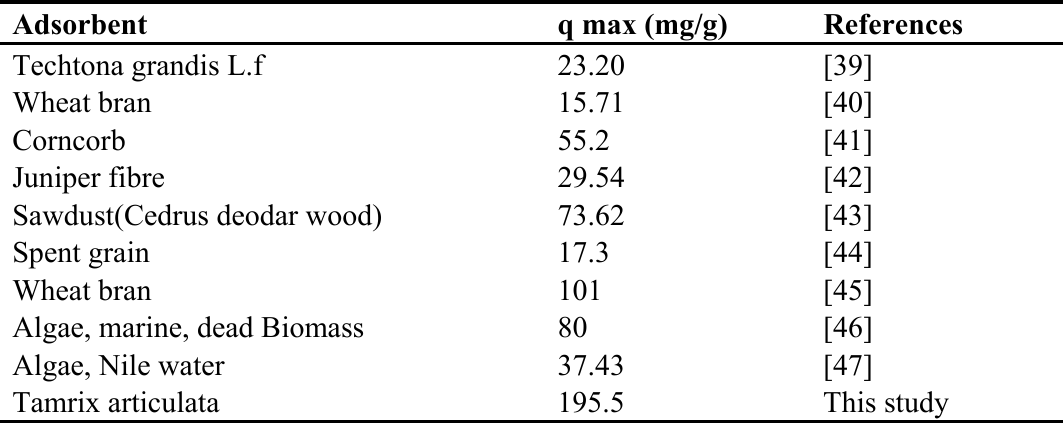
Table 5. Maximum adsorption capacities for cadmium adsorption to different adsorbents.